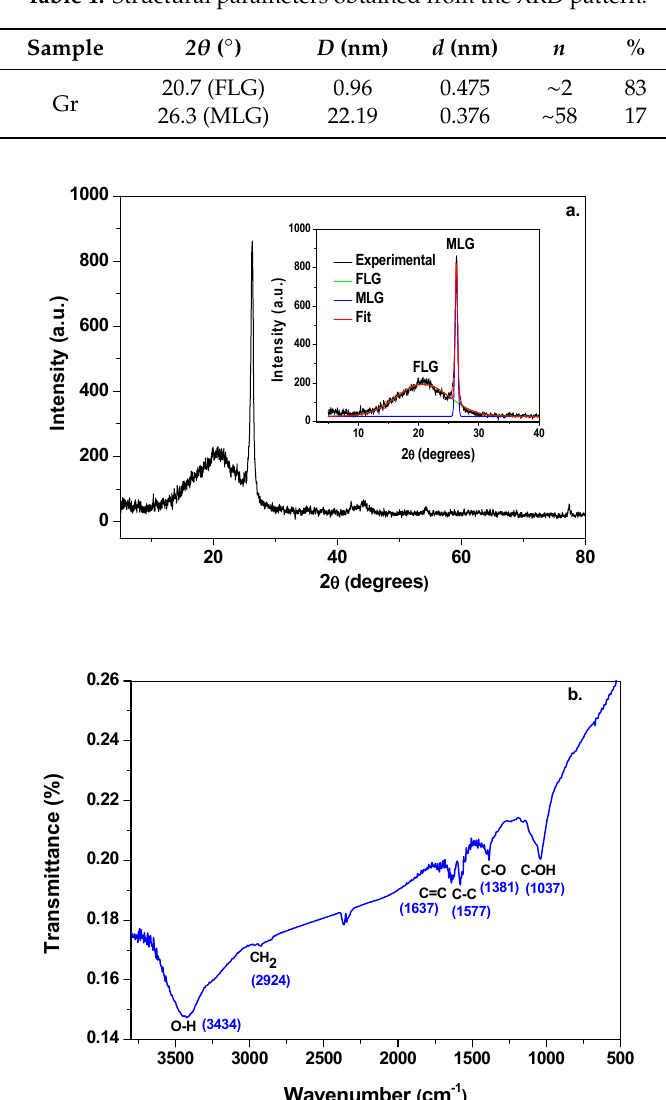
Figure 3. The XRD pattern of the graphene sample: recorded (black line); inset: deconvolution of the spectrum in FLG (green line), MLG (blue line), fitted spectrum (red line) ( a ); FTIR spectrum of graphene ( b ).